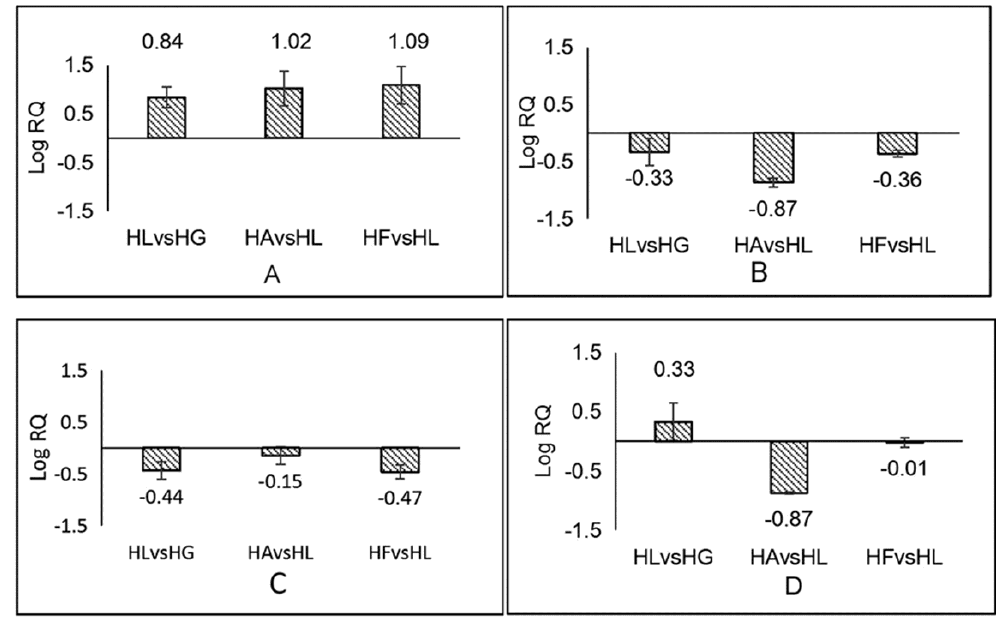
Figure 10. The results of qRT-PCR. “RQ” represented 2 −ΔΔ C t and “Log (RQ) > 0” means the gene was up-regulated, “Log (RQ) < 0” means the gene was down-regulated. ( A – D ) represented crtZ , crtISO , lcyB and ZEP , respectively.